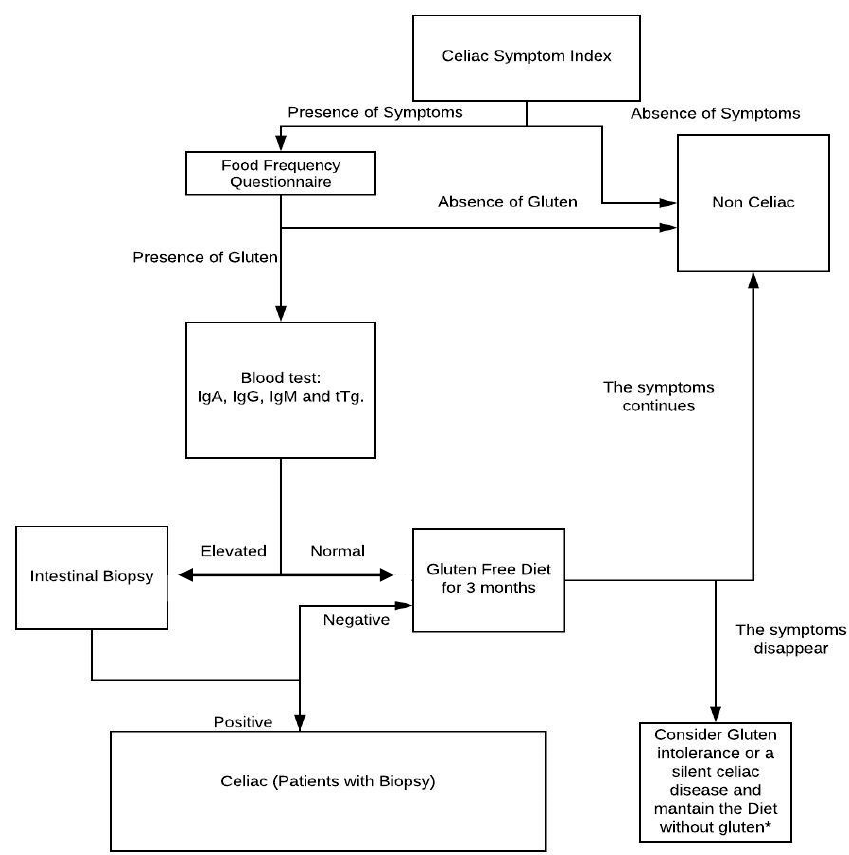
Figure 2. Flow diagram with the suggested steps to diagnose celiac disease. IgA: Immuno-globulin A, IgG: Immuno-globulin G, IgM: Immuno-globulin G, tTg: Transglutaminase anti-inflammatory. *